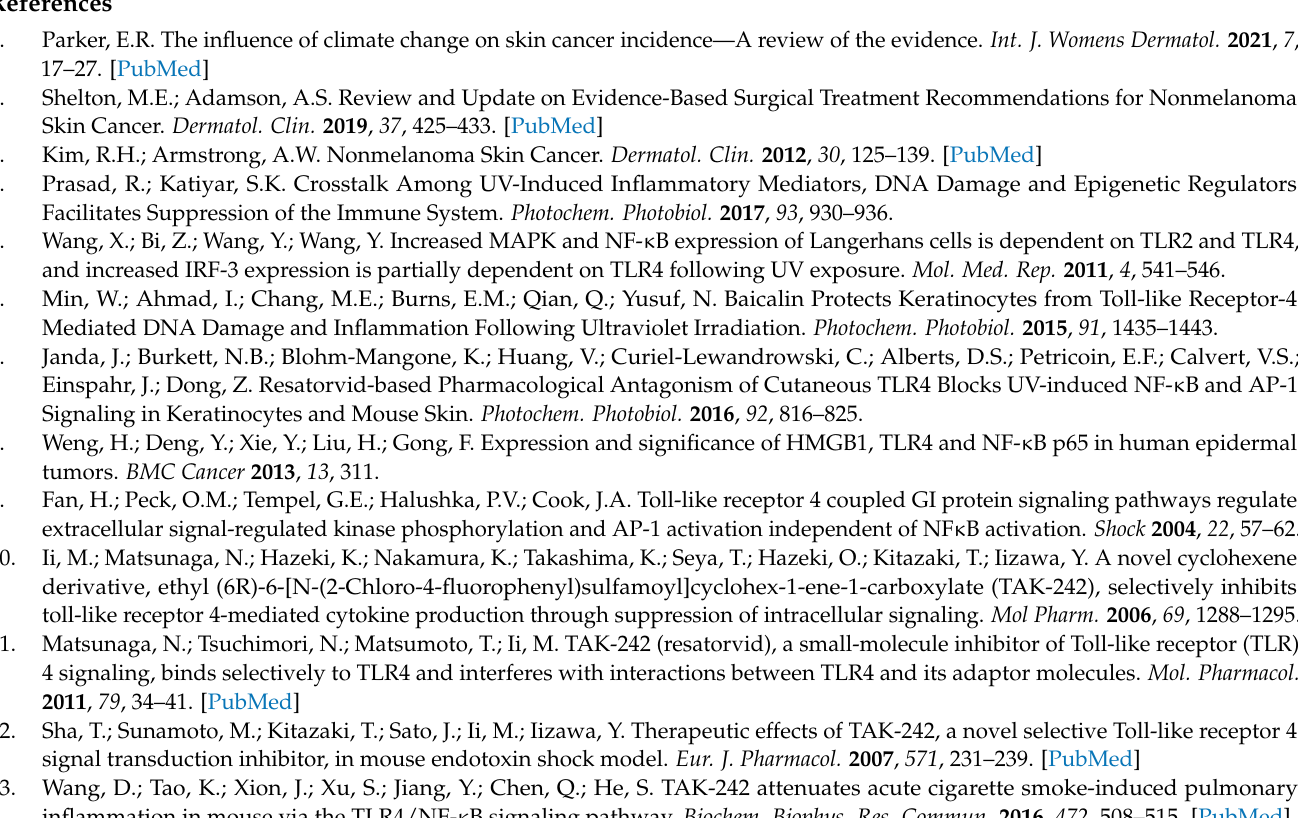
HSM images of raw resatorvid. Figure S6. Representative Raman spectra of raw resatorvid using 785 nm laser. Figure S7. ATR-FTIR spectrum of raw resatorvid. Table S1: DSC thermal analysis ( n = 3, mean ± standard deviation). Table S2. Residual water content quantified by KFT. ( n = 4, mean ± standard